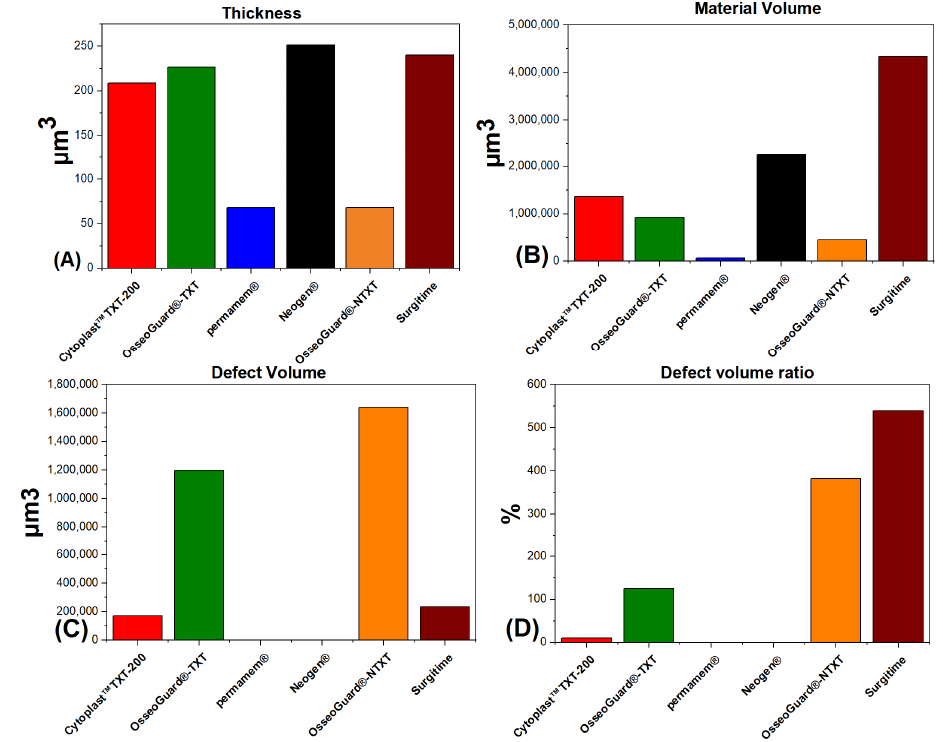
Figure 6. Diagrammatic representation of the nano-CT obtained results. ( A ) Thickness; ( B ) Material Volime; ( C ) Defect Volume; ( D ) Defect Volume Ratio. Table 5. Descriptive statistics for preplanned surface-type comparison groups.